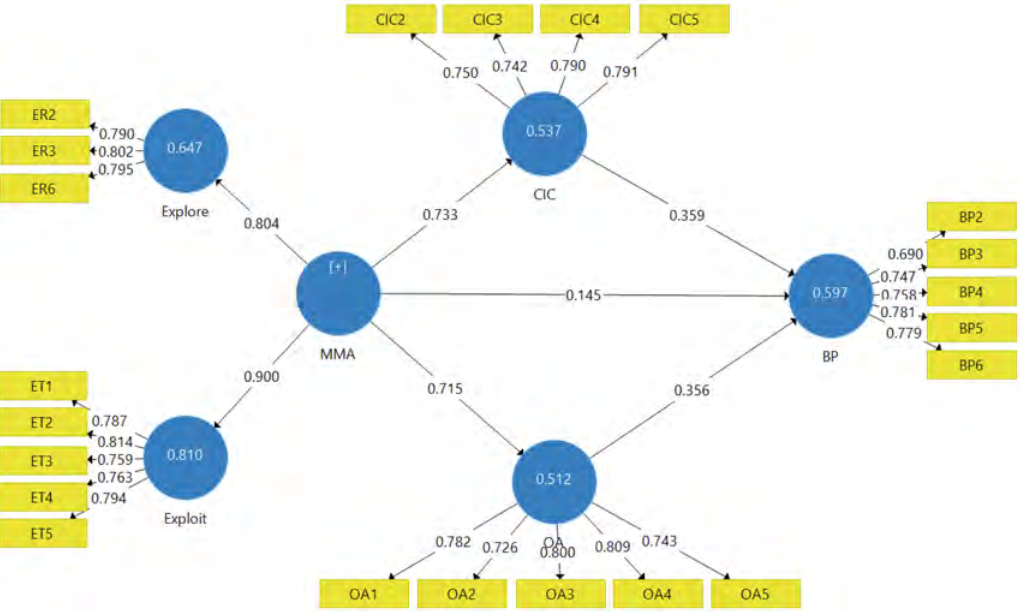
Figure 2. Loading factor of the research